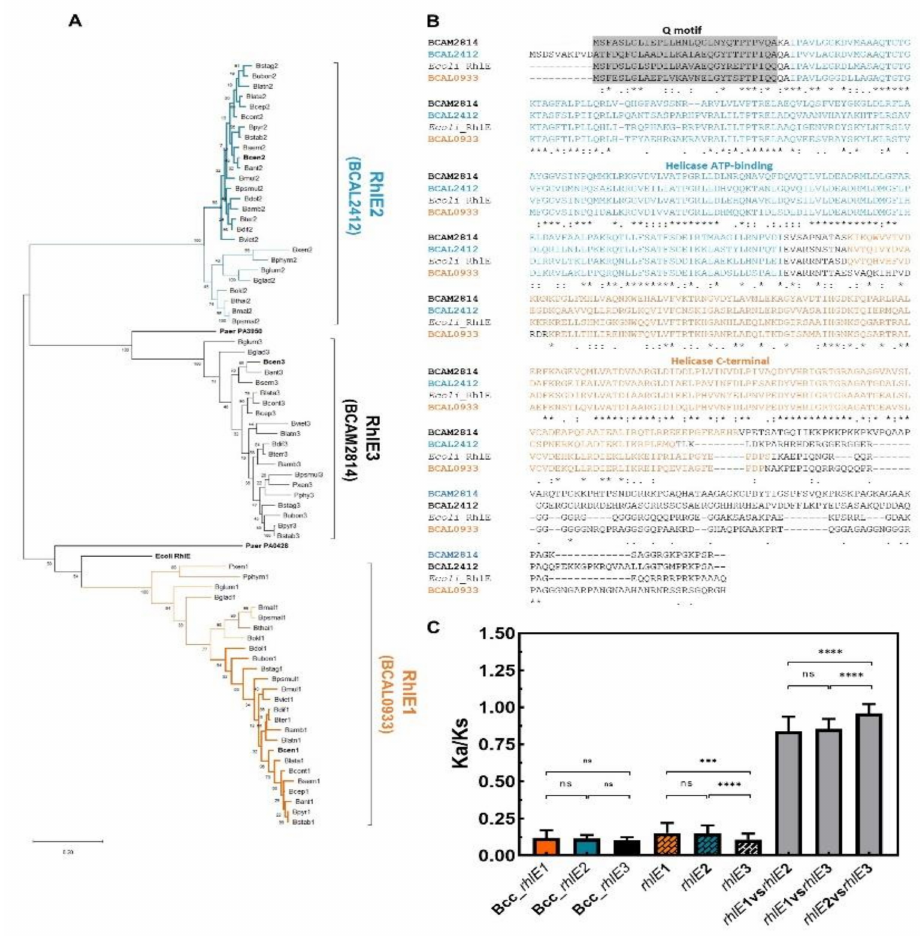
Figure 7. RhlE-like helicases encoded in genomes of Burkholderia species. ( A ) Phylogenetic tree constructed based on the alignment of 72 amino acid sequences from 24 species of Burkholderia genus and two Paraburkholderia species (Table S4). Sequences of E. coli and P. aeruginosa RhlE-like proteins were also included. The evolutionary relatedness was inferred using the maximum likelihood method and the Jones-Taylor-Thornton matrix-based model. The tree with the highest log likelihood ( − 16941.58) is shown. The percentage of trees in which the associated taxa clustered together is shown next to the branches. Initial tree(s) for the heuristic search were obtained by applying the neighbor-joining method to a matrix of pairwise distances estimated using a JTT model. The tree is drawn to scale, with branch length measured as the number of substitutions per site. Evolutionary analyses were conducted in MEGA X. ( B ) Alignment of the amino acid sequences of the RhlE-like helicases from B. cenocepacia J2315 and the E. coli RhlE. The Q motif is higlighted in grey. Asterisks (*) indicate identical amino acid residues, one (.) or two (:) dots indicate semi-conserved or conserved substitutions, respectively. ( C ) Mean Ka / Ks values of the di ff erent Bcc (colored bars) and Burkholderia bacteria (colored pattern bars), calculated using orthologs of rhlE1 , rhlE2 or rhlE3 genes and using paralogs rhlE genes from 11 Burkholderia species (grey bars). Error bars indicate standard deviation. The p -value was determined with the two-tailed Mann–Whitney test and represented by *** when p < 0.001, **** when p < 0.0001 or